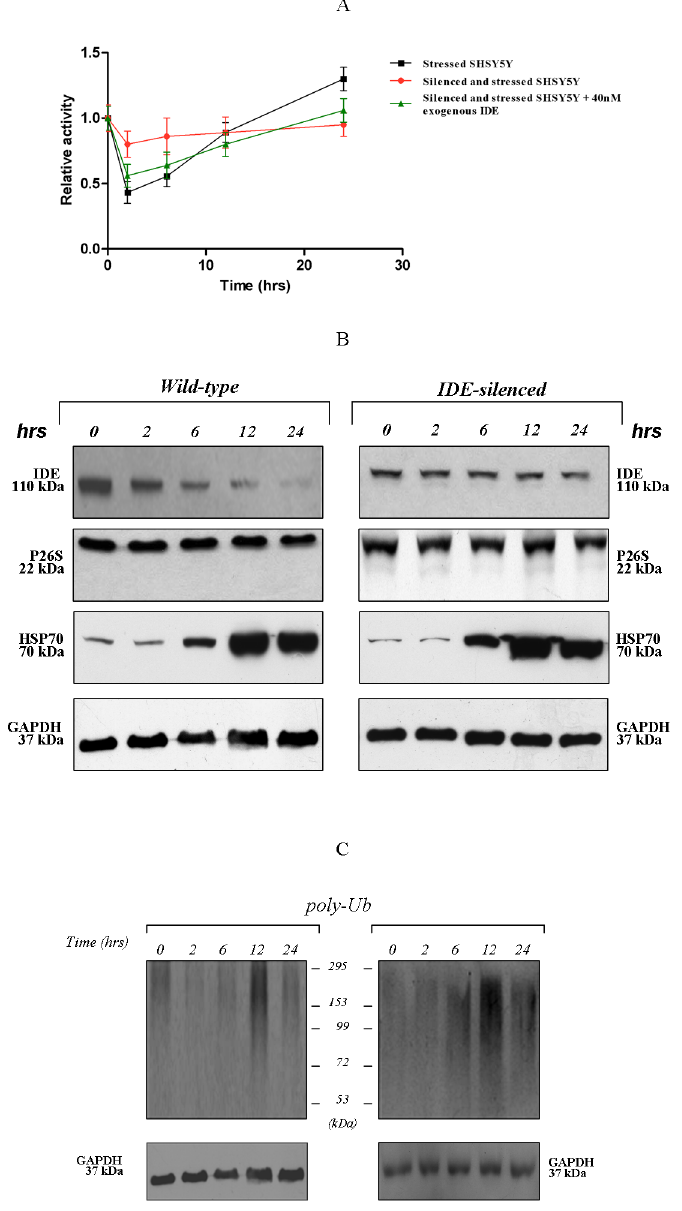
Fig 4. Time-course of 26S proteasome activity over the HSR and Western blotting analyses. (A) The chymotryptic-like activity of 26S proteasome particles partially purified from wild-type (black square), treated (red circle) and in presence of 10 – 40 nanomol/L exogenous IDE added to extracts from treated cells (green triangle), was assayed through the proteasome assay: the relative activity represents the ratio between the velocity of degradation of 200 micromol/L fluorogenic substrate at time 0 (resting conditions) vs the indicated time of recovery. The reaction was followed over 3 h of incubation at 37°C. Results presented are the means +/- S.E. of five independent experiments * ( p < 0.05, one way ANOVA, followed by Tukey ’ s test, n = 15). Western blotting analysis of crude cell extracts: (B) Filters were probed with antibodies specific for: IDE (110 kDa), 26S proteasome (22 kDa), HSP70 (70 kDa), GAPDH (37 kDa). (C) Filters were probed with a polyclonal antibody specific for ubiquitin. A representative immunoblot of five independent experiments is